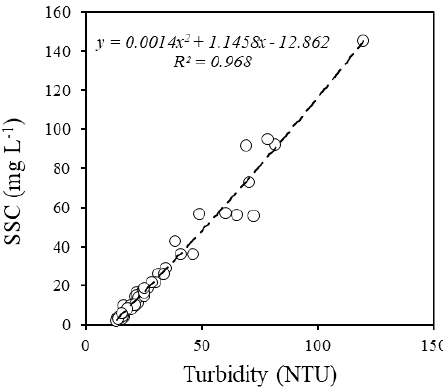
Figure 2. Relationship between the river water turbidity and suspended sediment concentration (SSC) measured at the down- stream boundary of the model domain (monitoring period: 1– 14 March 2017; n =